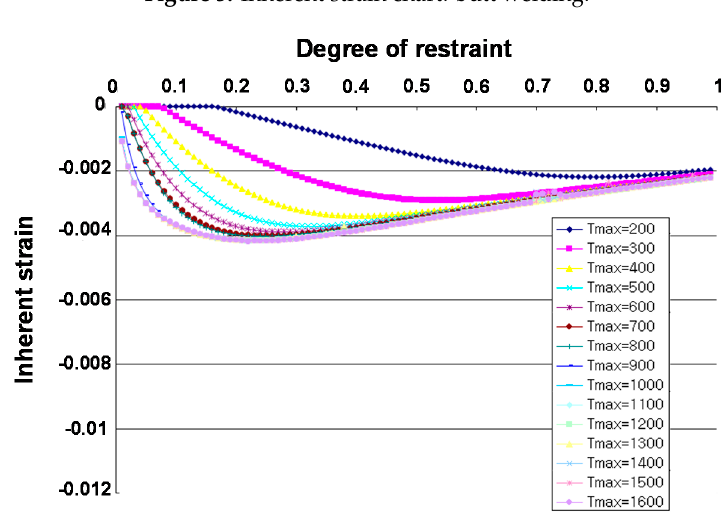
Figure 4. Inherent strain chart: fillet welding ( y -direction).